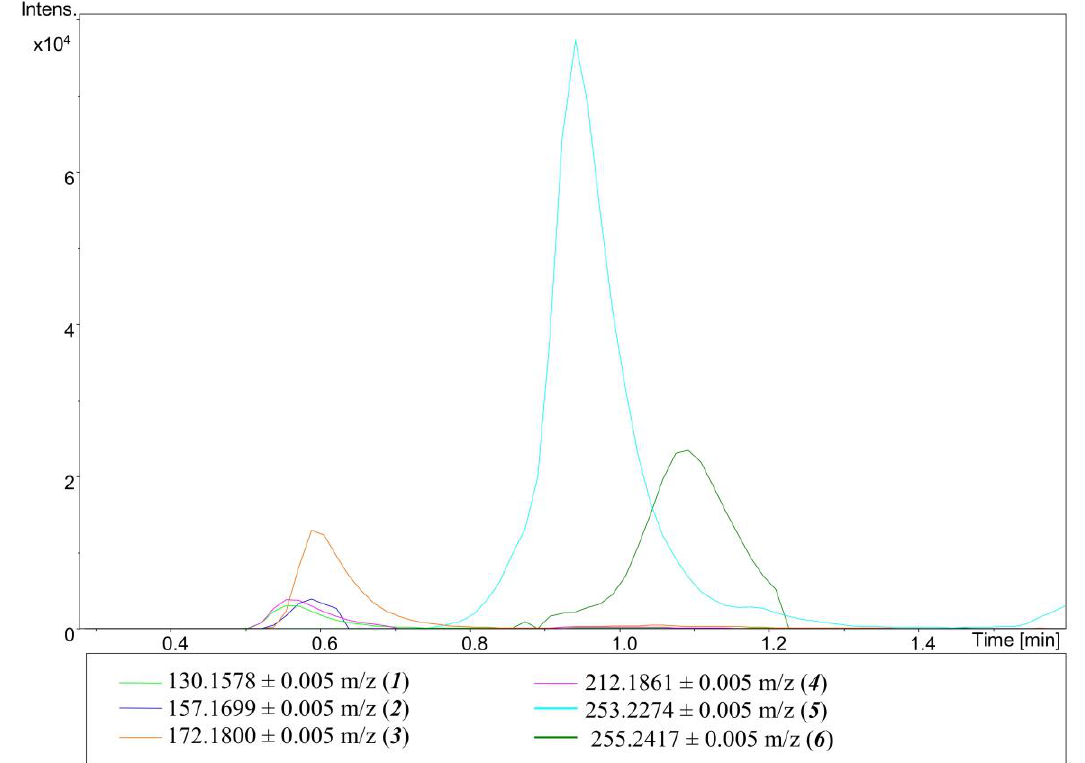
Molecules 2021 , 26 , x FOR PEER REVIEW Figure 2. Chromatogram obtained for a mixture of ALX and 5.25% NaOCl–H2O 1:49 ( v / v ). The numbers in the brackets correspond with the numbers in Table 1. Table 1. Compounds identified as generated in the reaction between ALX and NaOCl . No.